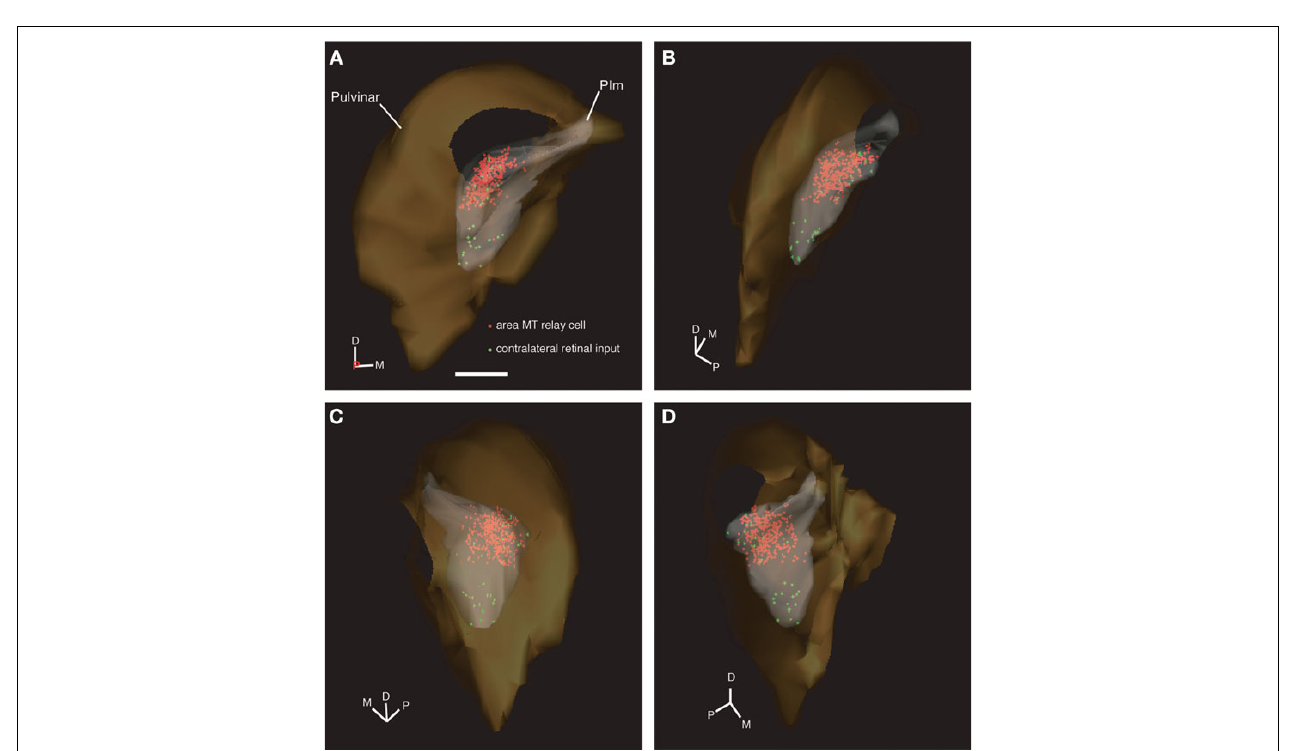
closer to the PIcm. Retinal input, although sparse, was also restricted principally to the PIm, with two separate zones of terminals being observed in the dorsal and ventral region of the PIm. Sections are presented in sequence along the anteroposterior axis, starting at the most posterior end (A 1.3 mm) to the most anterior section (A 2.7 mm). Adjacent sections immunostained for calbindin-D28k were used to delimit pulvinar subnuclei. L, lateral; V, ventral; scale bar = 1 mm.